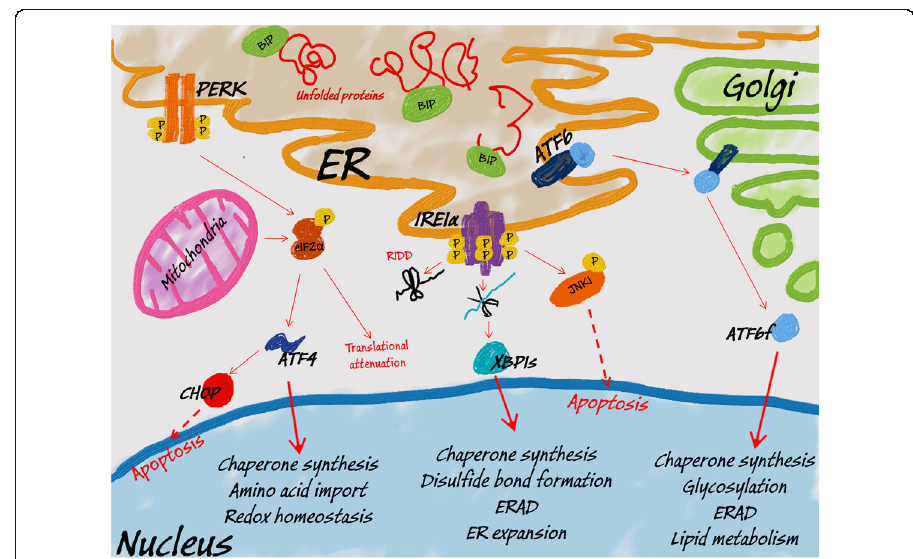
Fig. 2 UPR and UPRmt signaling. Upon buildup of misfolded/unfolded proteins in ER, BIP is released from ER membrane to induce PERK dimerization and its subsequent autophosphorylation. Activated PERK phosphorylates the eIF2 α , leading to global translation attenuation. Some transcripts, however, including ATF4 remain preferably translated. ATF4 provides the transcriptional signal to restore ER homeostasis, however, it can also induce proapoptotic CHOP. Similarly, accumulation of unfolded proteins in mitochondria leads to PERK activation and the induction of ATF4 signaling (UPRmt). Upon its dissociation from BIP, IRE1 α undergoes oligomerization and autophosphorylation and thus gains endoribonuclease activity. To decrease the ER load, activated IRE1 α degrades mRNAs and miRNAs (RIDD). IRE1 α also performs splicing of XBP1 mRNA to release transcriptionally active XBP1s. XBP1s activates a transcriptional program to restore ER homeostasis. Alternatively, IRE1 α can activate a proapoptotic kinase JNK1. Finally, BIP dissociation allows ATF6 translocation to Golgi, where cleavage of this protein results in release of transcriptionally active ATF6f. ATF6f activates a transcriptional program to restore ER homeostasis and support